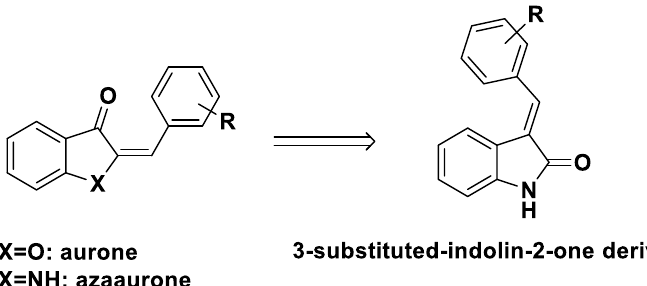
Figure 2. Rational design of 3-substituted-indolin-2-one derivatives.